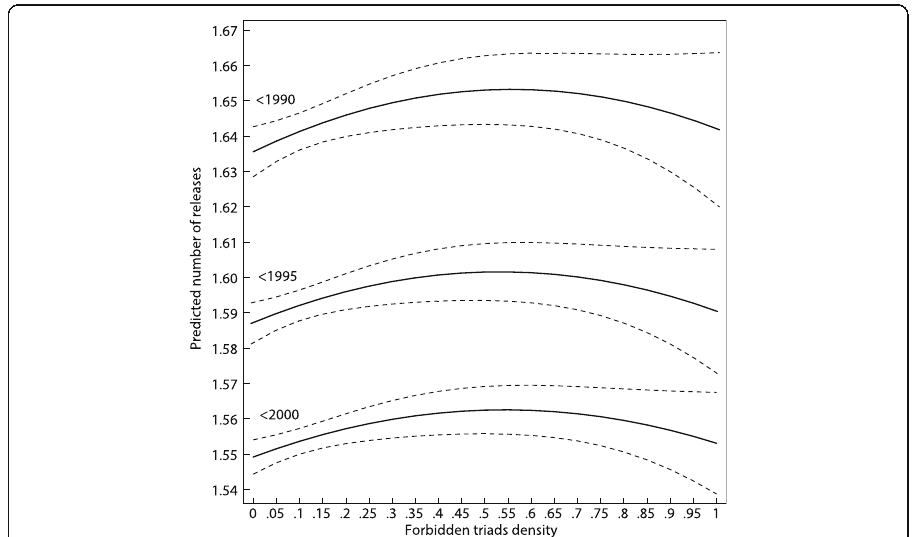
Fig. 12 Marginal effects for forbidden triads density using the fixed effects OLS specification for three right- hand time